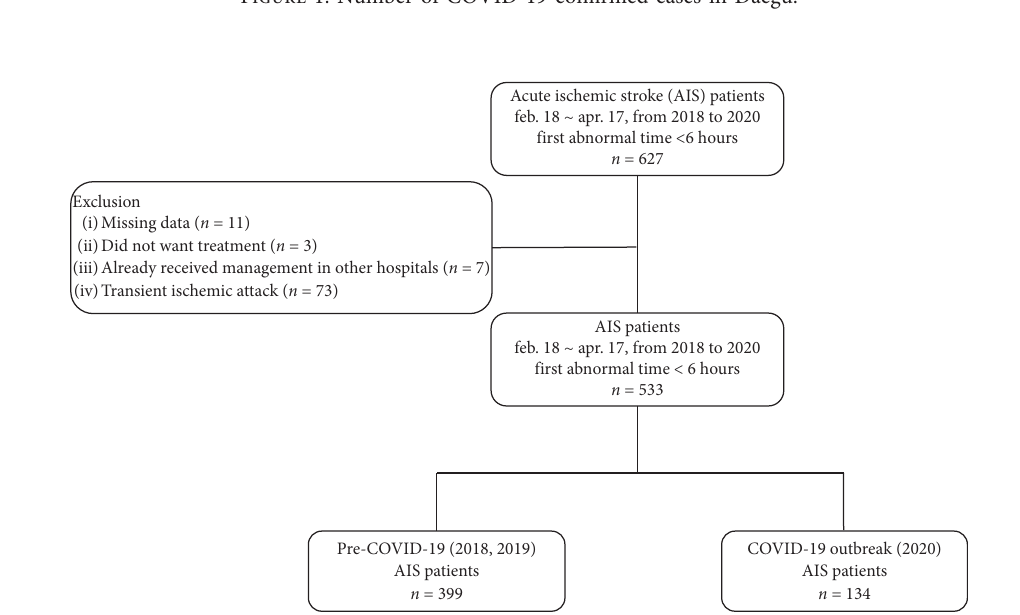
Figure 1: Number of COVID-19-confirmed cases in Daegu.